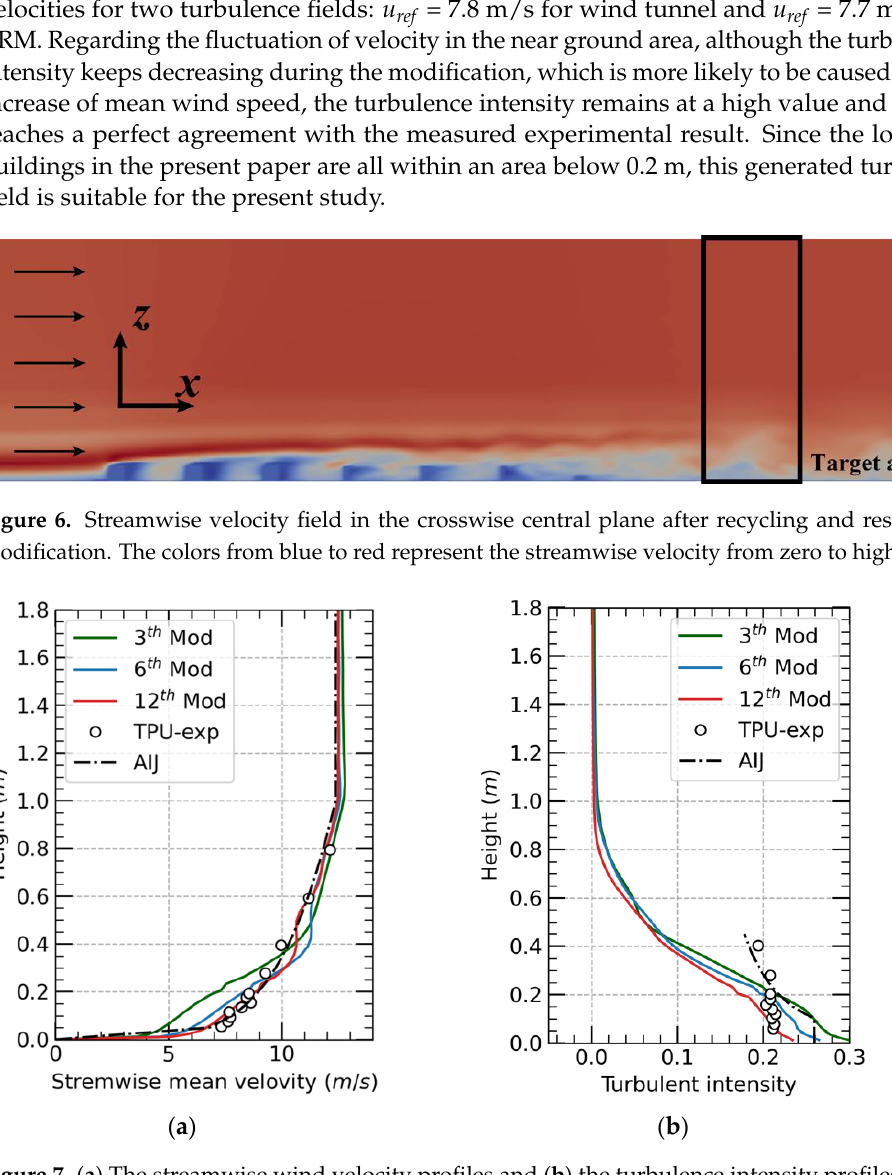
( c ) Figure 8. The vertical profiles of the integral length scales of the numerical turbulence field. ( a ) the profiles of streamwise velocity ( b ) the profiles of crosswise velocity ( c ) the profiles of vertical ve- locity.